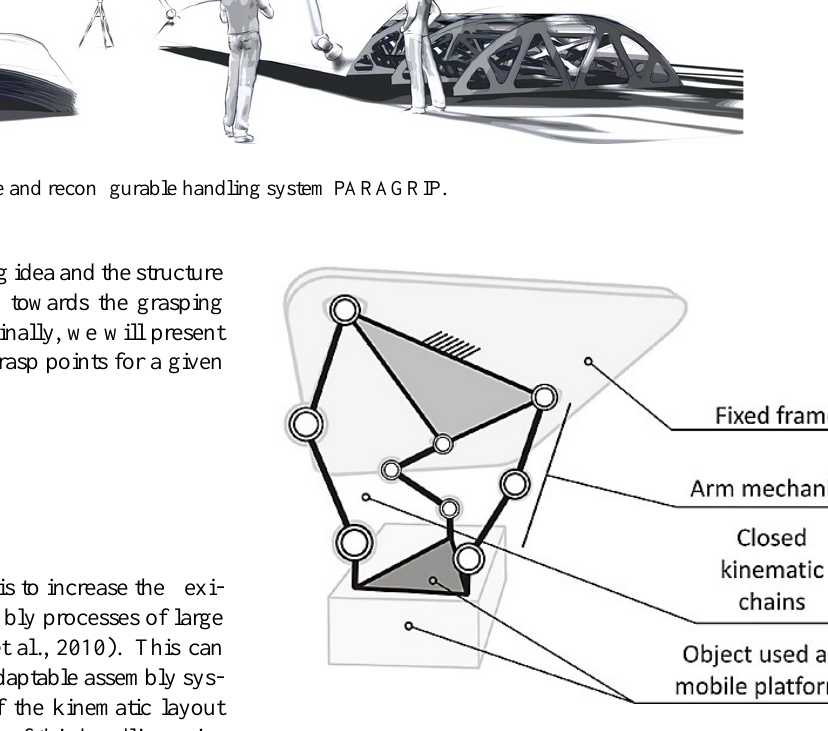
Figure 2. New handling